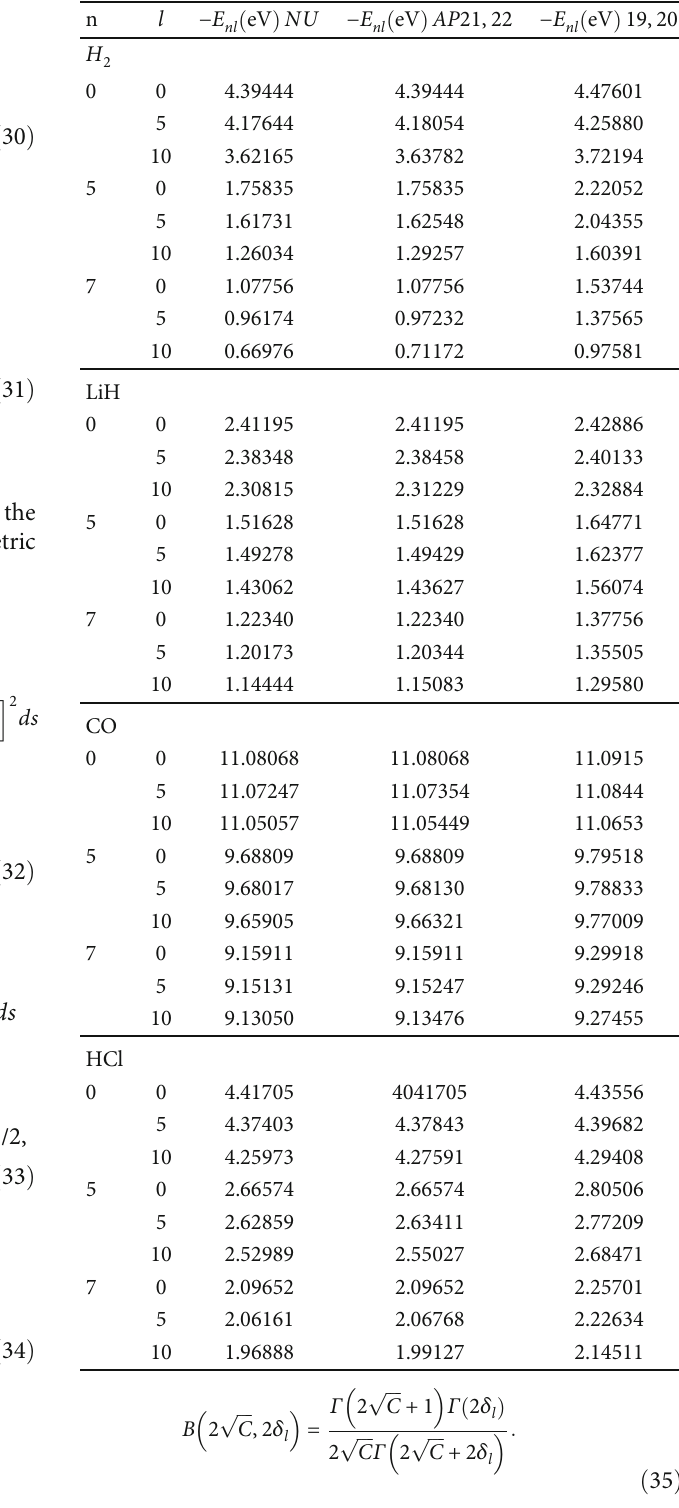
Table 2: The energy levels for a few diatomic molecules obtained from the sDF and Morse oscillator